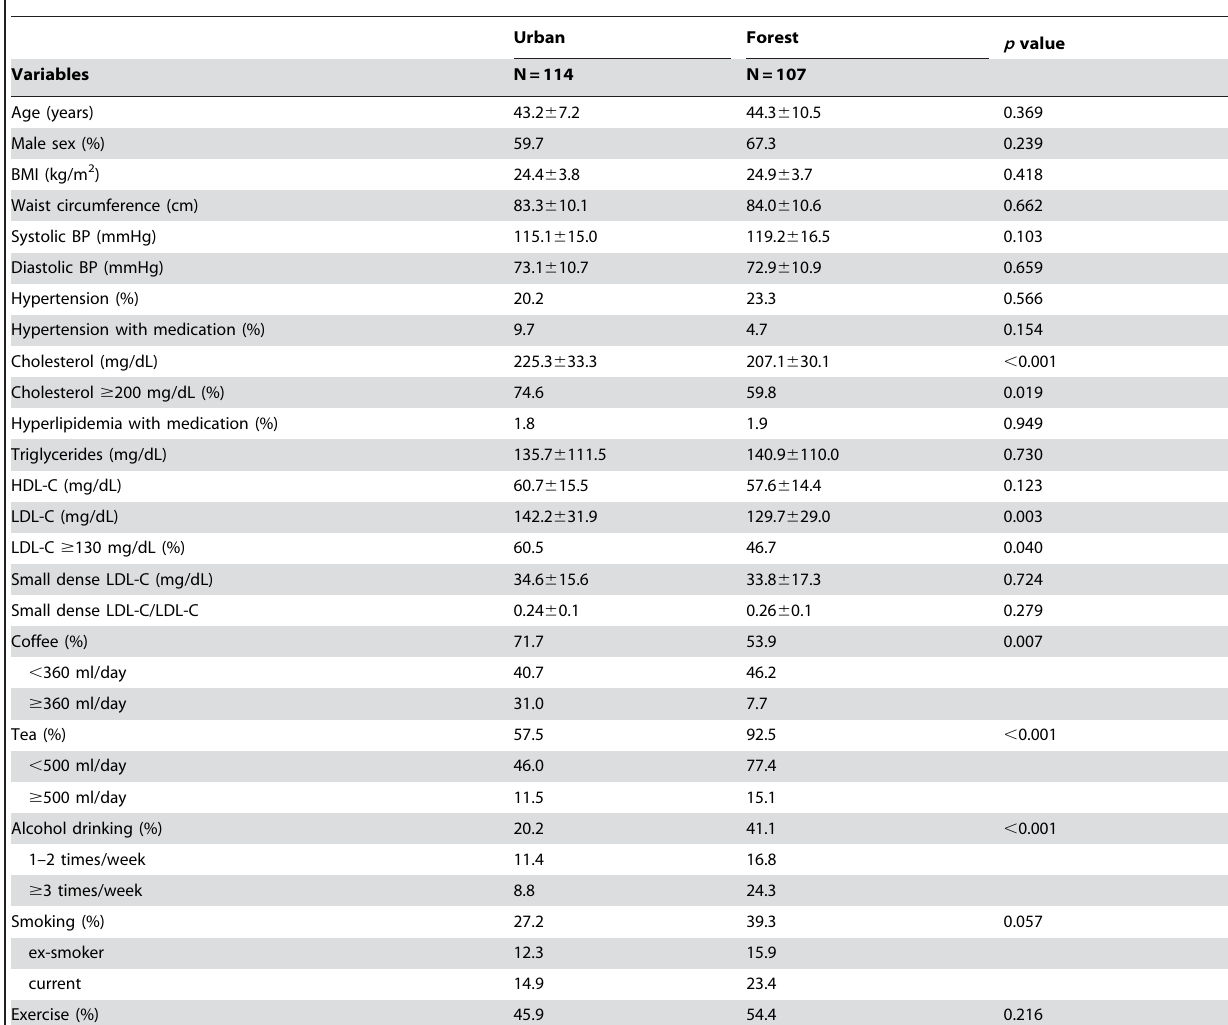
Table 1. General characteristics of urban and forest staff member